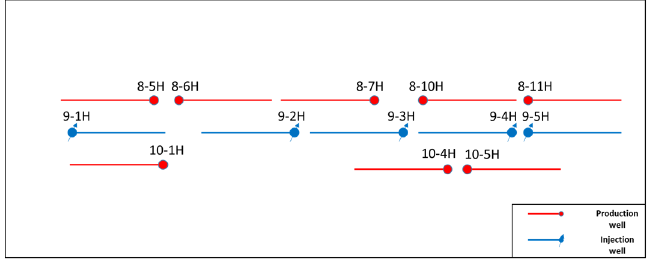
Figure 12. Horizontal well pattern in the study area. The circles represent wellhead positions.